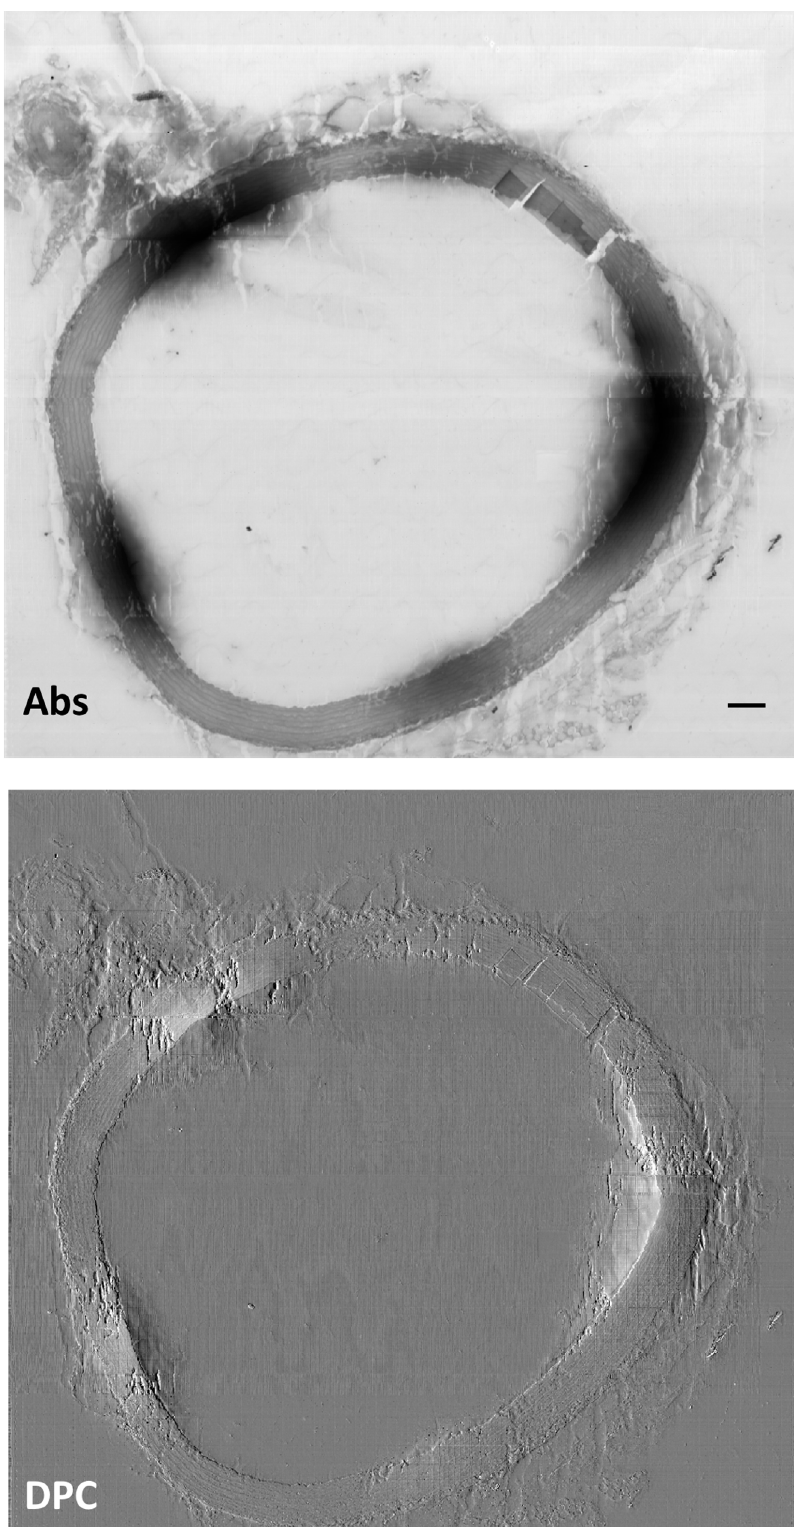
Figure 11. Absorption (Abs) and differential contrast image (DPC) of a section of coronary artery from a rat [81], acquired at a 1.5 keV excitation energy with a 2.5 µm step size, over an area of 2100 µm × 2000 µm. Scale bar is 100 µm.